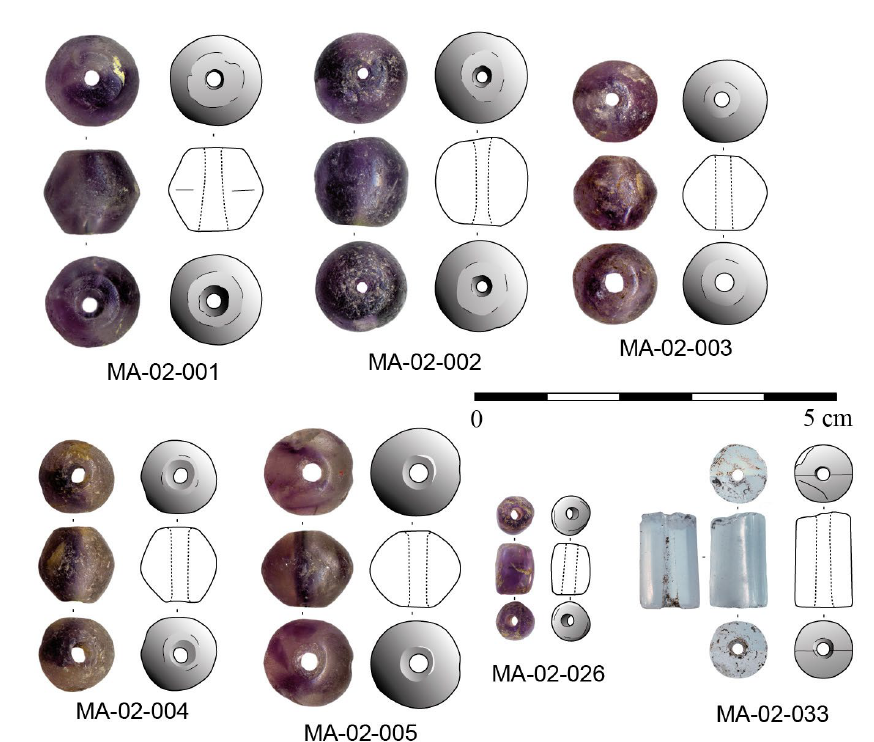
Figure 5: Photographs and drawings of the beads of Vivé (MA-02),